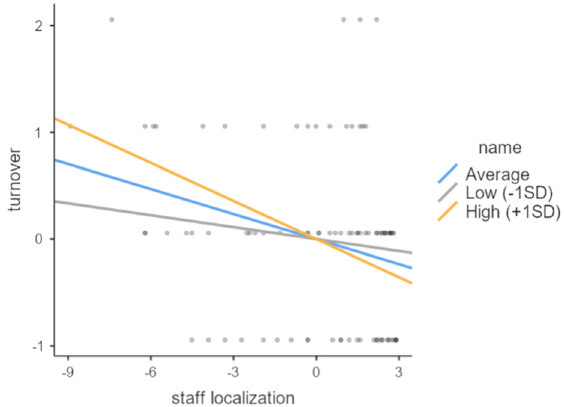
Figure 2. Moderating effect of subsidiary CEO on the relationship between staff localization and turnover rate.